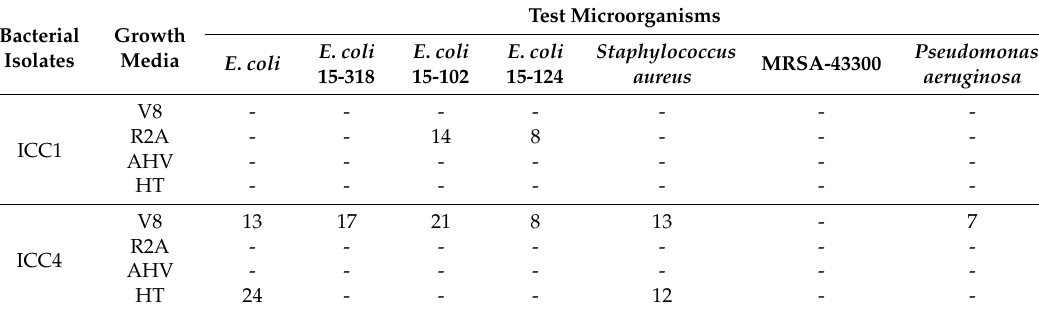
Table 1. Antimicrobial activities. ICC4 (Closest relative: Streptomyces spp.) and ICC1 (Unidentified bacterium). The numerical in the boxes indicated the diameter of zones of inhibition in mm.